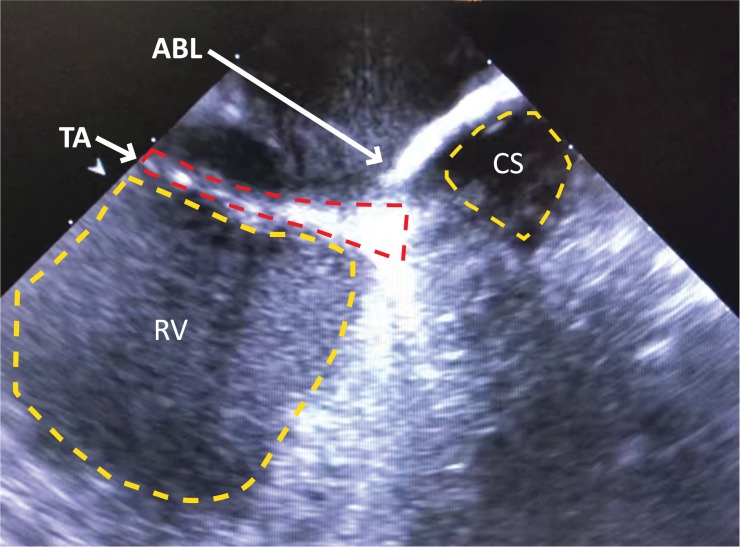
ICE recording confirms site tricuspid annulus (TA) and coronary sinus (CS) to assist with location of His bundle.Representative ICE recording confirming the location of the ablation catheter tip (ACT) at the site of the TA relative to the ostium of the CS and the right ventricle (RV).